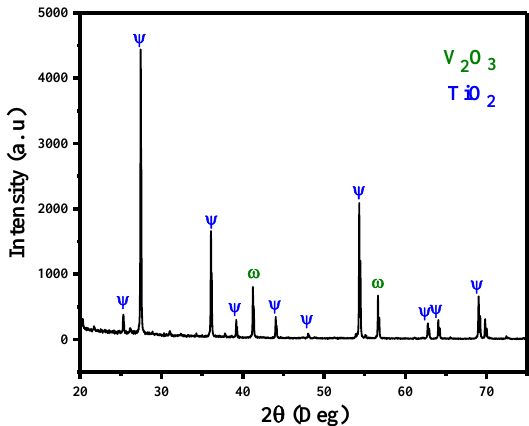
Figure 1. XRD of the fabricated V@TiO 2 nanocomposite.